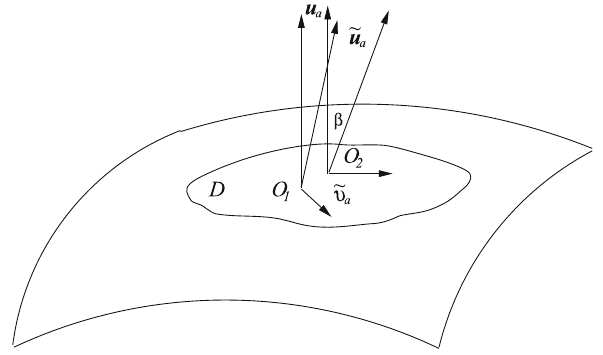
Fig. 1 Observers ( O 1 and O 2 ) living inside the bulk-flow domain ( D ) and moving with (local) peculiar velocity ˜ v a relative to the Hubble expansion. The 4-velocities u a and ˜ u a define the CMB frame and the coordinate system of the peculiar motion respectively (see Eq.